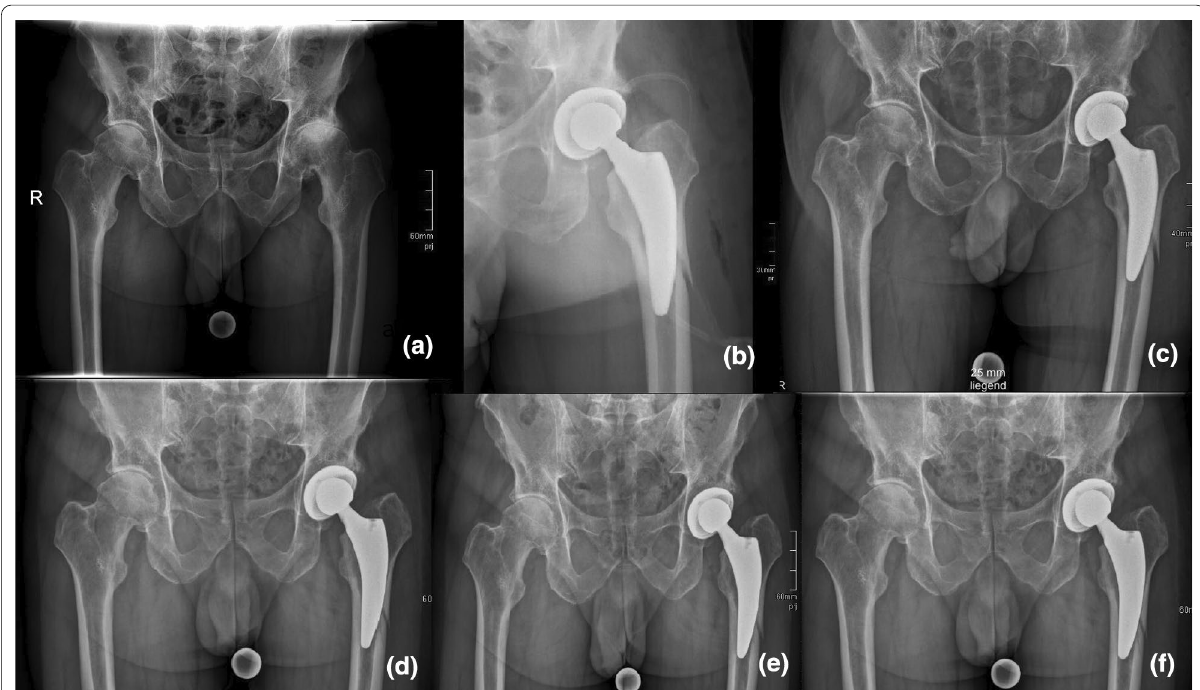
Fig. 3 Intraoperative fracture treated without revision surgery; detected on day of surgery on postoperative x-ray with patient already outside the operating theater; patient did not give informed consent for revision surgery; conservative treatment with 6 weeks without weight-bearing; a preoperative, b postoperative, c discharge at home; d 6 weeks after surgery; e 3 months after surgery; f 1 year after surgery